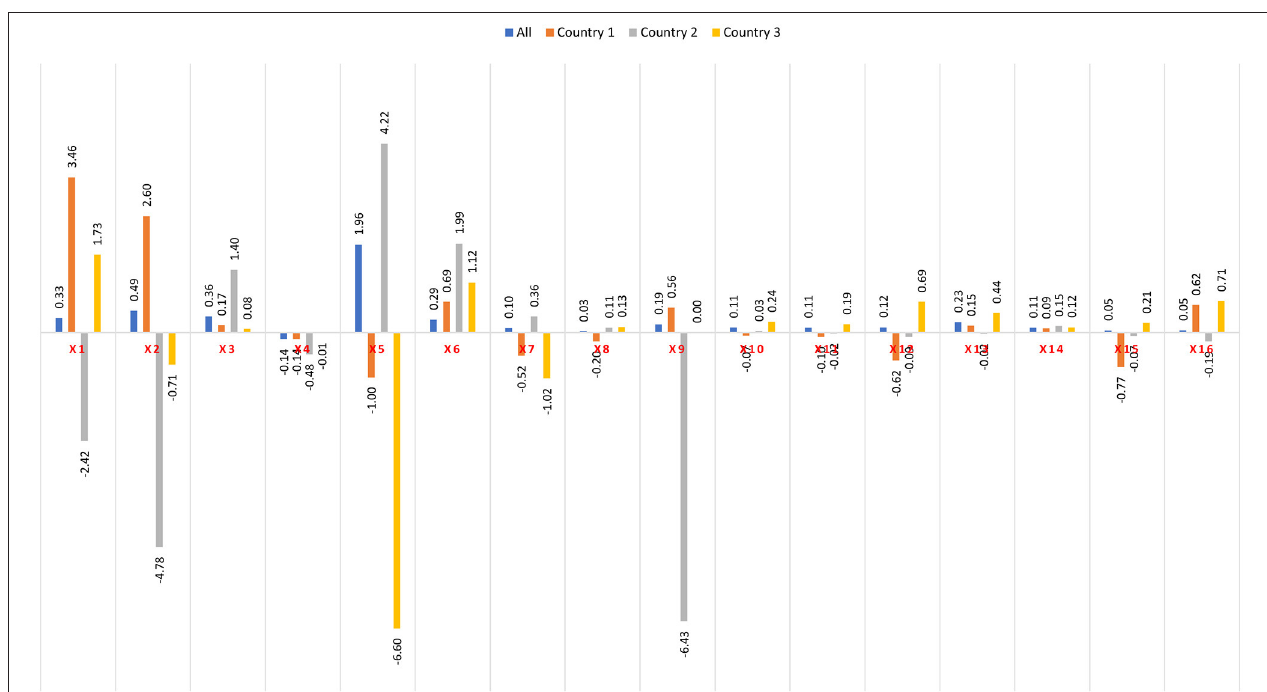
FIGURE 9 | Feature importance of predictors in a pooled set and in each country/territory (1 = Mainland China, 2 = India, and 3 = UAE).